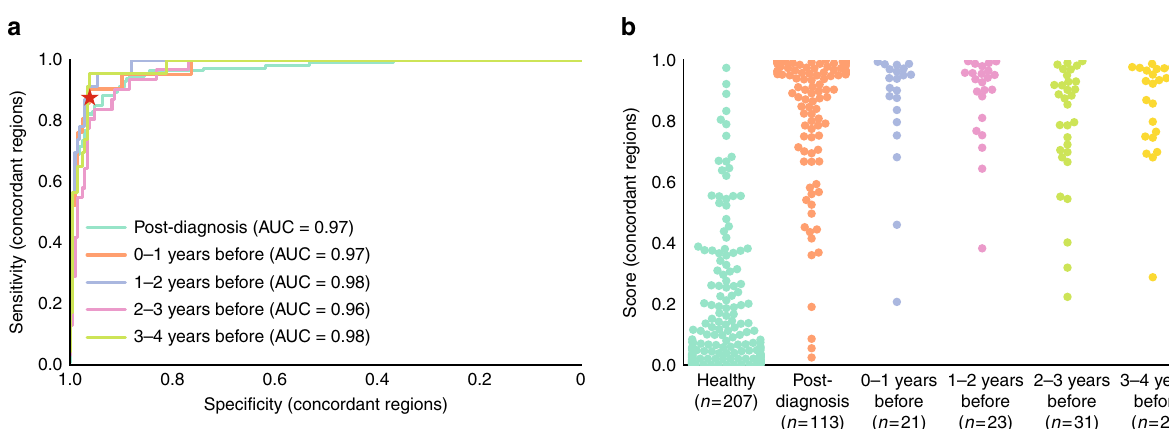
Fig. 3 Performance of PanSeer using only tissue-concordant genomic regions. All presented results used only the test set samples, and only utilized target regions showing concordant hyper/hypo-methylation between training set cancer plasma samples and cancer tissue samples. Dots represent the logistic regression (LR) score. a Receiver operator characteristic curves (ROC) and area under the curve (AUC) values. The red star shows the cutoff value derived from the training set. Separate curves are shown for post-diagnosis samples and pre-diagnosis samples (divided by years before diagnosis). b LR scores by years before